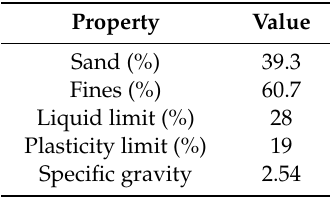
Table 1. Geotechnical properties of the soil [2].